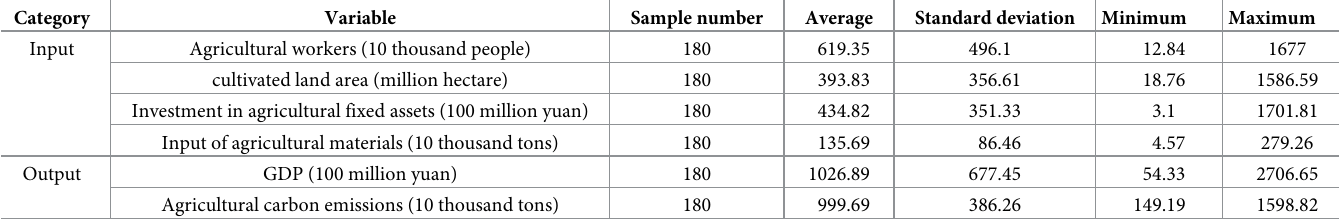
Table 3. Descriptive statistical results of